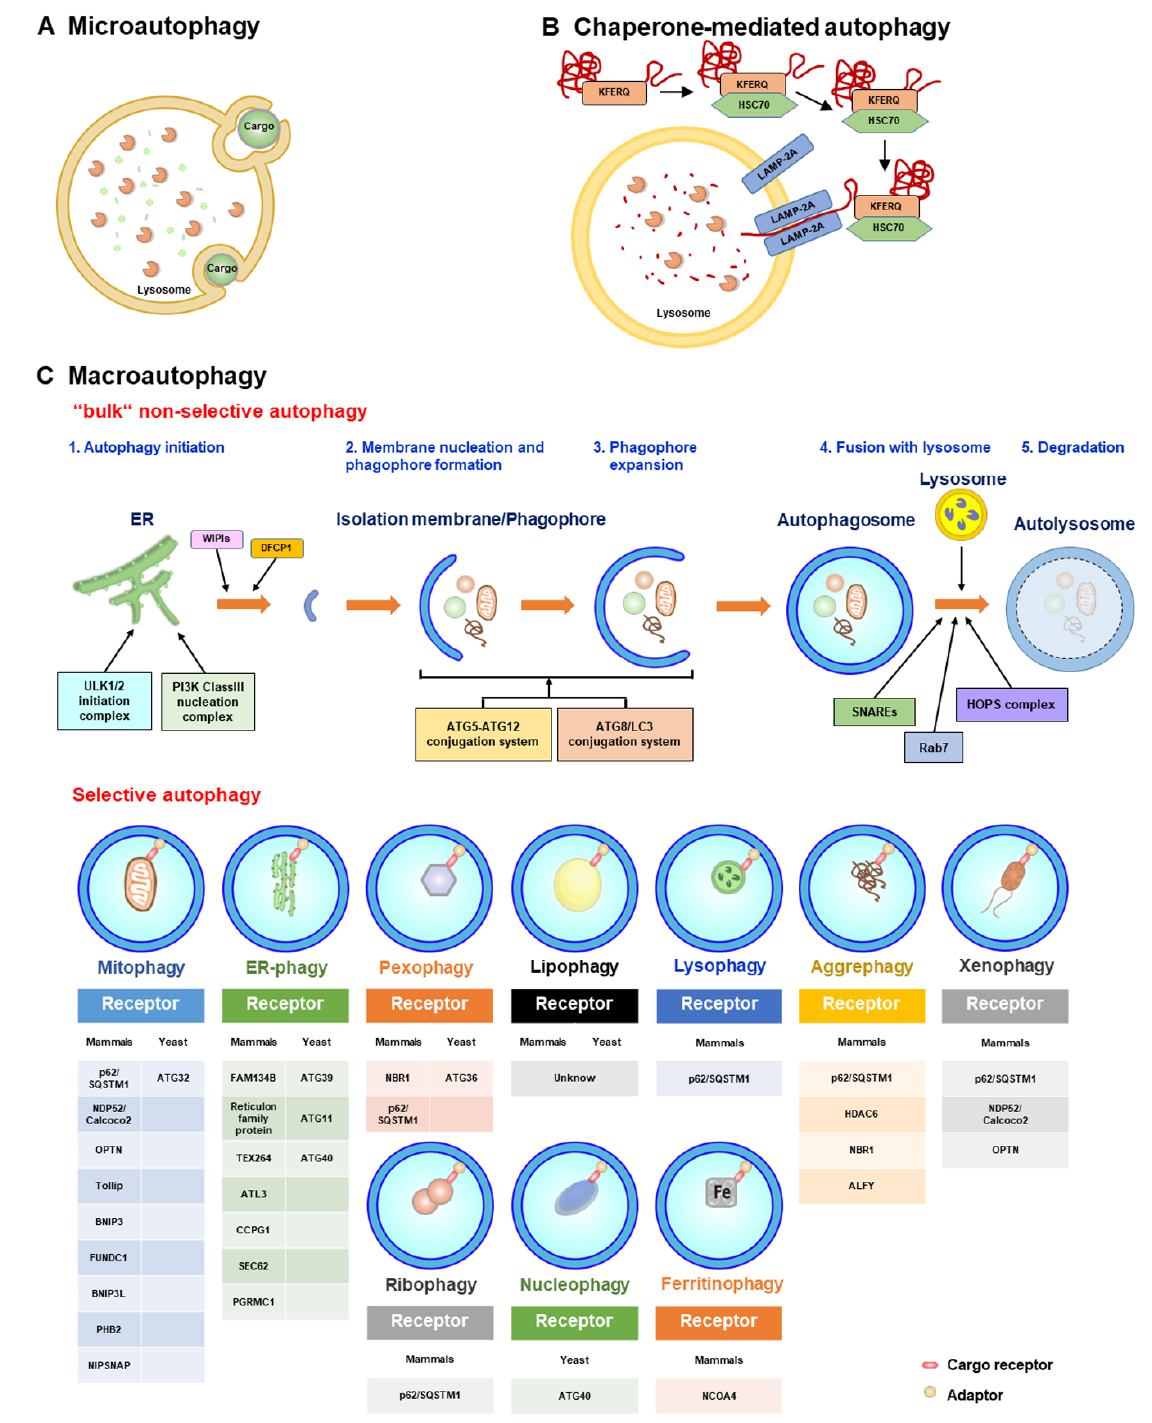
Figure 3. Three modes of autophagy and regulatory processes: ( A ) Microautophagy involves the invagination and/or protrusion of the lysosomal membranous structure for the engulfment of cytosol materials, including organelles, and the transfer of these materials to the lysosome lumen for degradation. ( B ) CMA recognizes the cargoes containing a KFERQ (Lys-Phe-Glu-Arg-Gln) motif by heat shock cognate 70 kDa protein (HSC70). Through docking with lysosomal membrane protein 2A (LAMP2A) on the membrane of lysosomes, the cargoes are delivered to the lysosomal lumen for degradation. ( C ) Macroautophagy is a vacuole biogenesis process consisting of membrane rearrangement events. The signaling cascade involved in the nutrient-starvation-induced